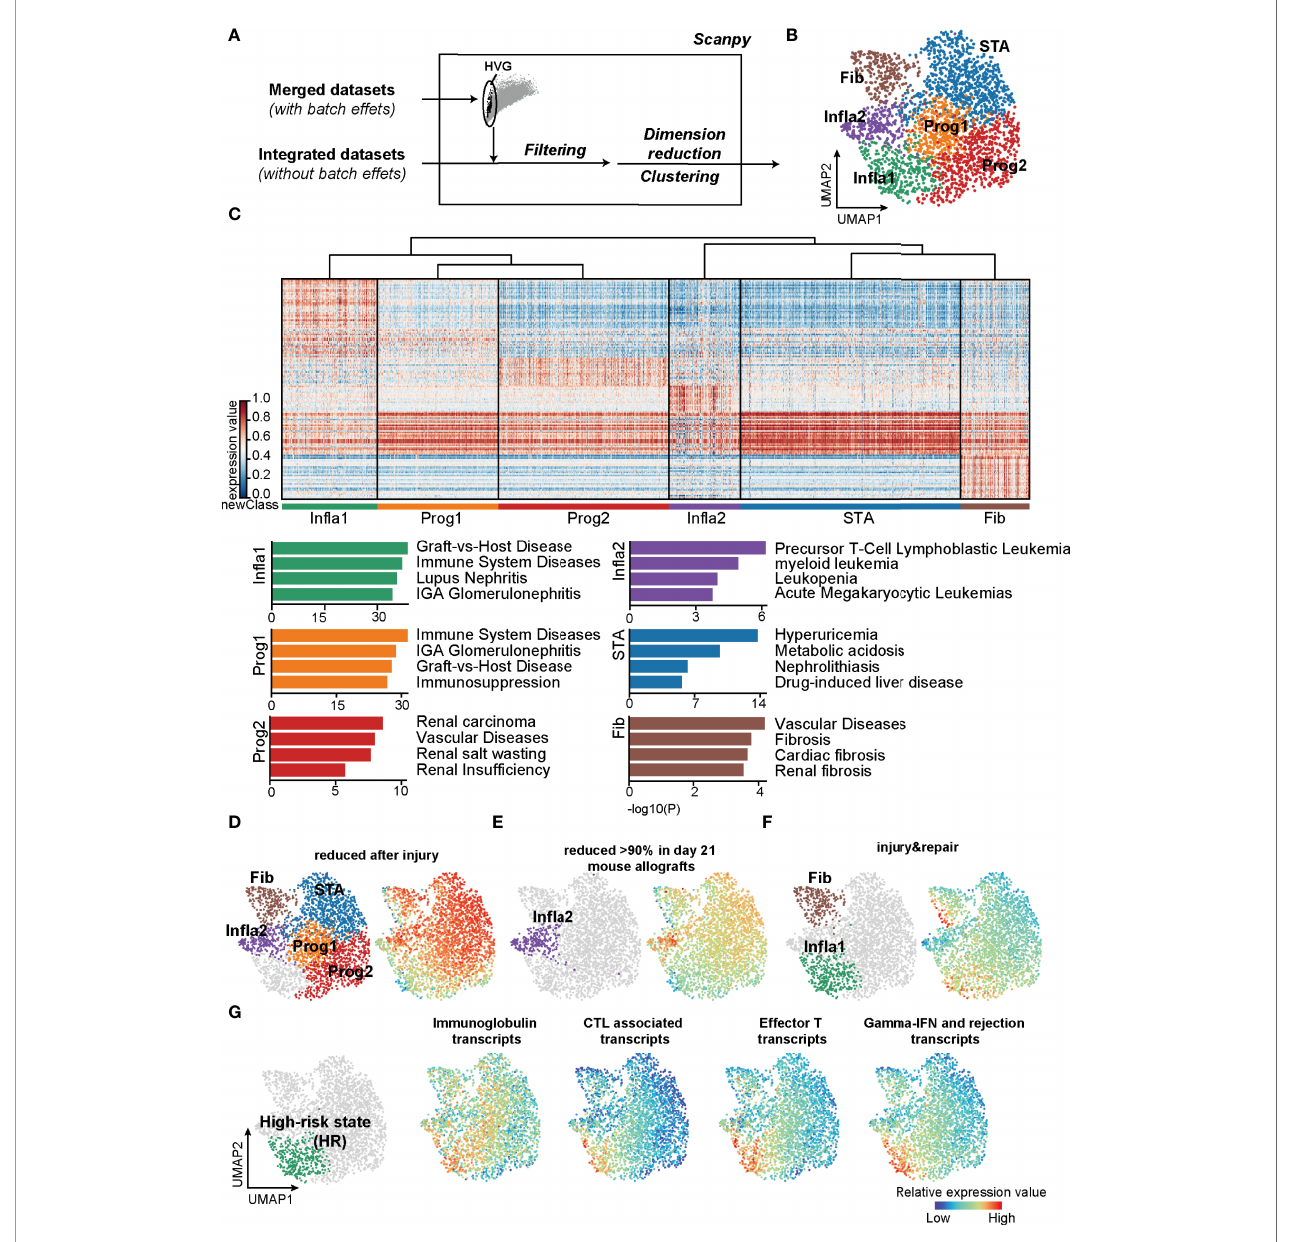
FIGURE 1 | Classi fi cations based on the unsupervised algorithms revealed a high-risk rejection state prone to allograft lost. (A) The fl owchart of reclassi fi cation towards renal transplantation rejection. HVG, highly variable genes. (B) UMAP plot showing annotations of the 6 newly de fi ned rejection states. In fl a1, in fl ammatory state 1; Prog1, progressive state 1; Prog2, progressive state2; In fl a2, in fl ammatory state 2; STA, stable state; Fib, fi brosis state. (C) Heatmap showing signature genes of each rejection state (left panel) and the enriched disease terms for the corresponding state (right panel). (D – F) Transcripts from different rejection phenotypes from mouse allograft datasets were enriched in the corresponding rejection states. (G) Enrichment of transcripts presenting high risk of graft failure in In fl a1. CTL, cytotoxic T